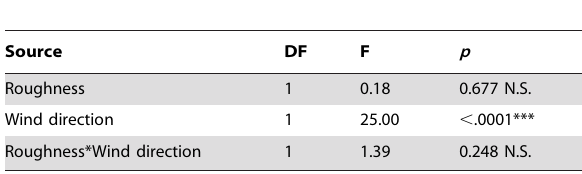
Table 2. Effects of beach roughness and wind speed on proportion of C. dorsalis media larvae that wheeled.